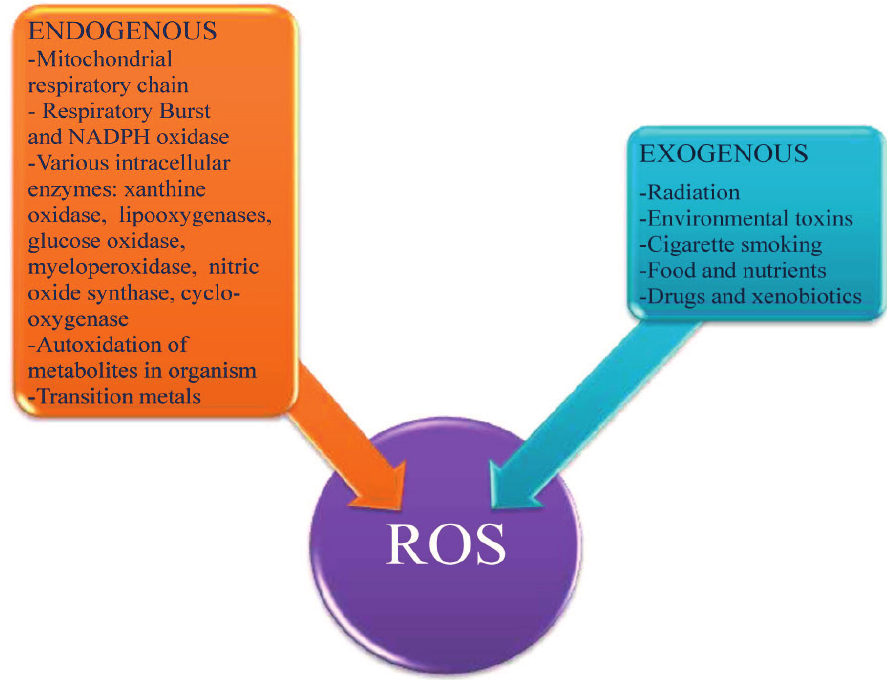
Figure 3. Endogenous and exogenous factors inducing ROS